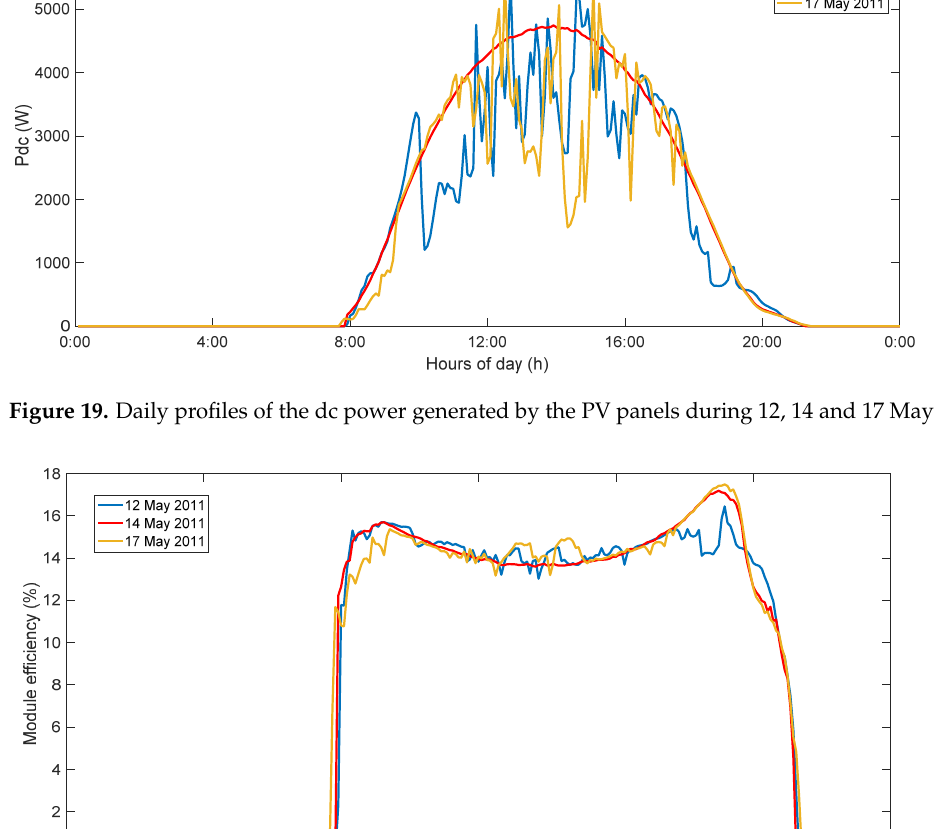
Figure 18. Daily profiles of the working voltage of the PV modules during 12, 14 and 17 May 2011.